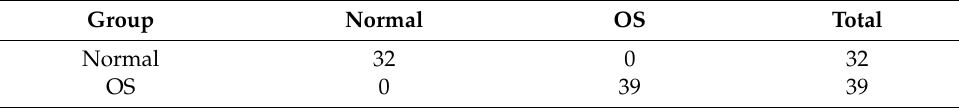
Table 3. The accuracy of this model in the validation group. Group